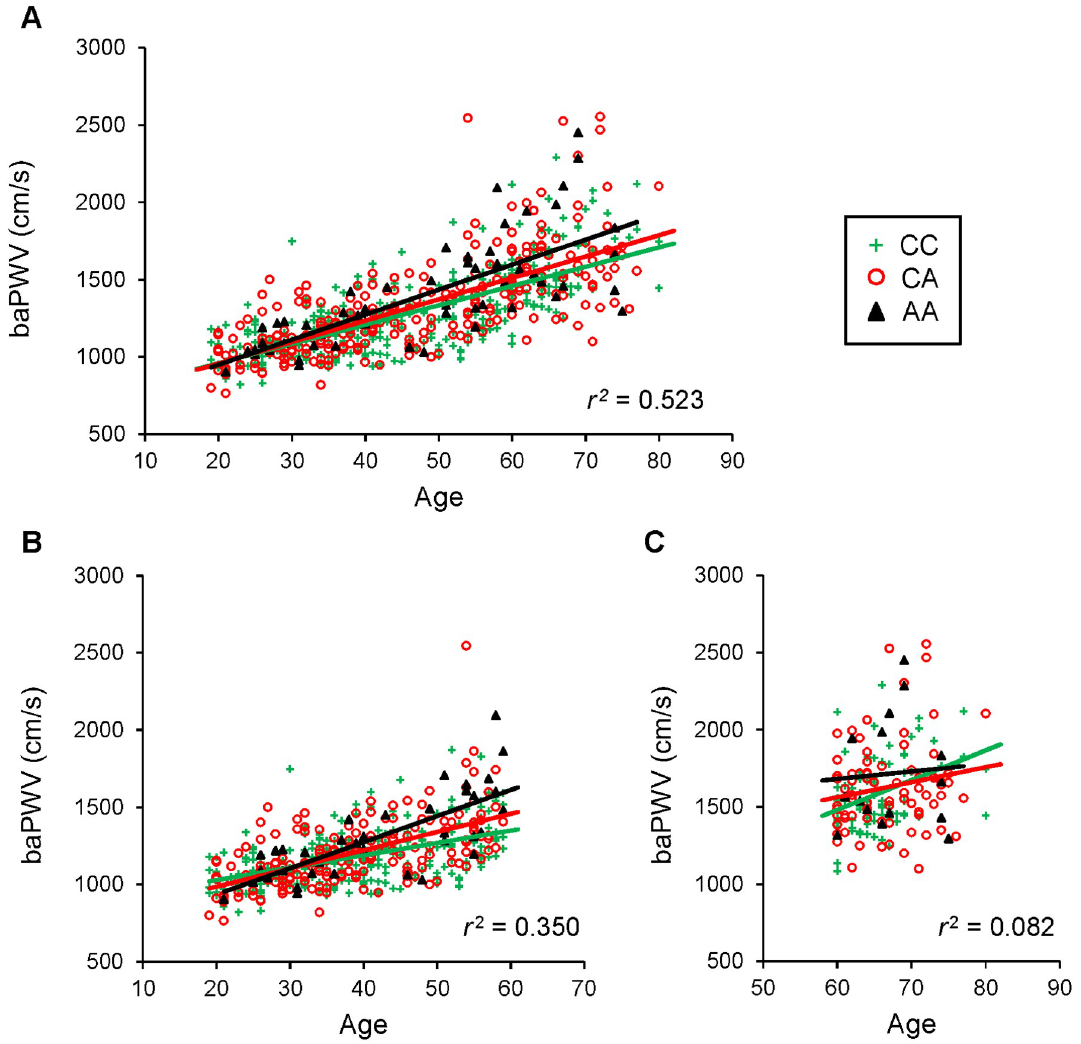
Fig 3. Arterial stiffness and blood pressure were affected by the interaction between NRF2 SNP − 617 and age. The scatterplot representing the relationship between baPWV and age divided into NRF2 SNP − 617 carriers (color: green, CC; red CA; black, AA) A) in all never-smoking healthy subjects, B) in those under 60 years old and C) in those over 60 years old. The coefficient of determination ( r 2 ) was calculated by standardized multiple linear regression analyses for baPWV using 5 characteristics, i.e., NRF2 SNP − 617 (CC vs CA), SNP − 617 (CC vs AA), age, interaction between SNP − 617 (CC vs CA) and age, and interaction between SNP-617 (CC vs AA) and